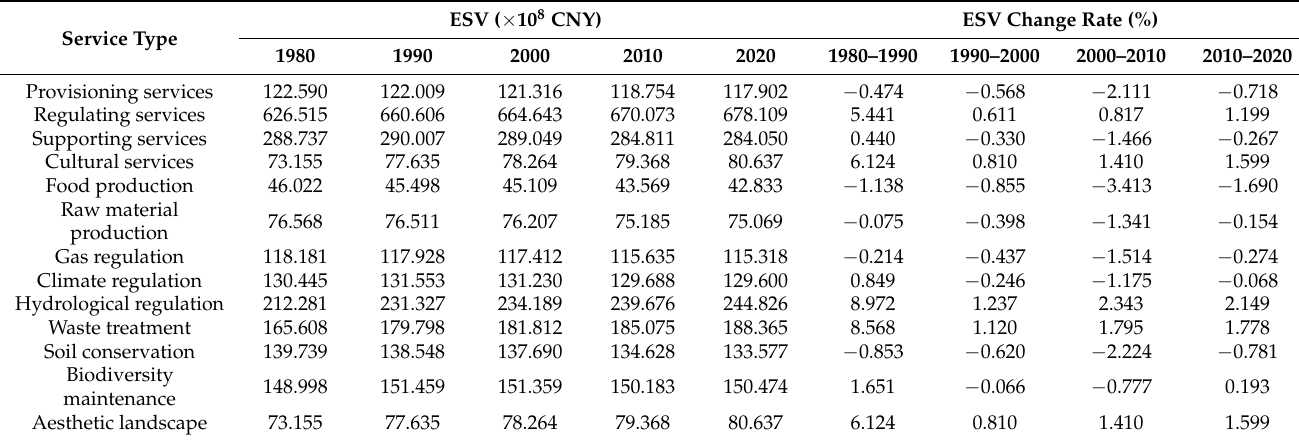
Table 6. Change in each ecosystem service value during